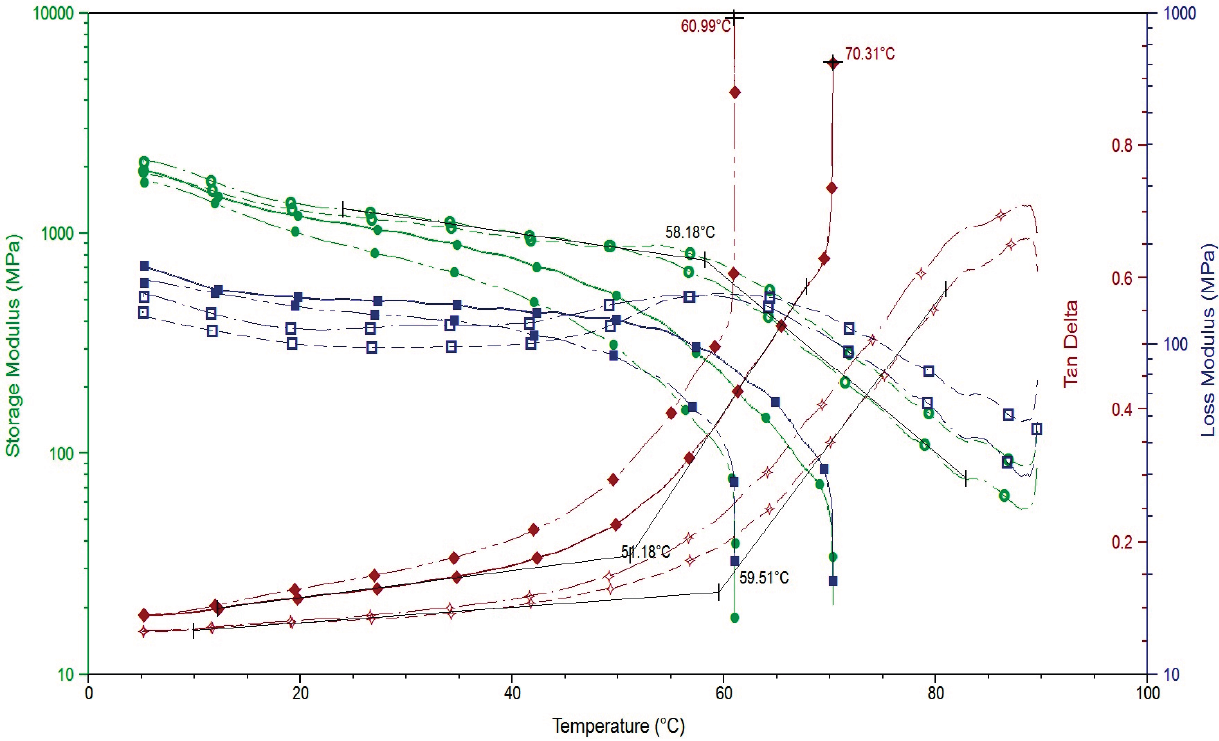
Figure 8. T -ramp duplicates at 30% RH for 0.04–0.05 mm CaCas/Gly films after pre-conditioning for four hours (green ( ● ) = E '; dark blue ( ■ ) = E ''; brown ( ♦ ) = Tan δ ) or six hours (green ( ○ ) = E '; dark blue ( □ ) = E ''; brown (  ) = Tan δ